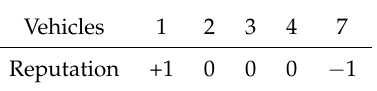
Table 3. Reputation for fraud